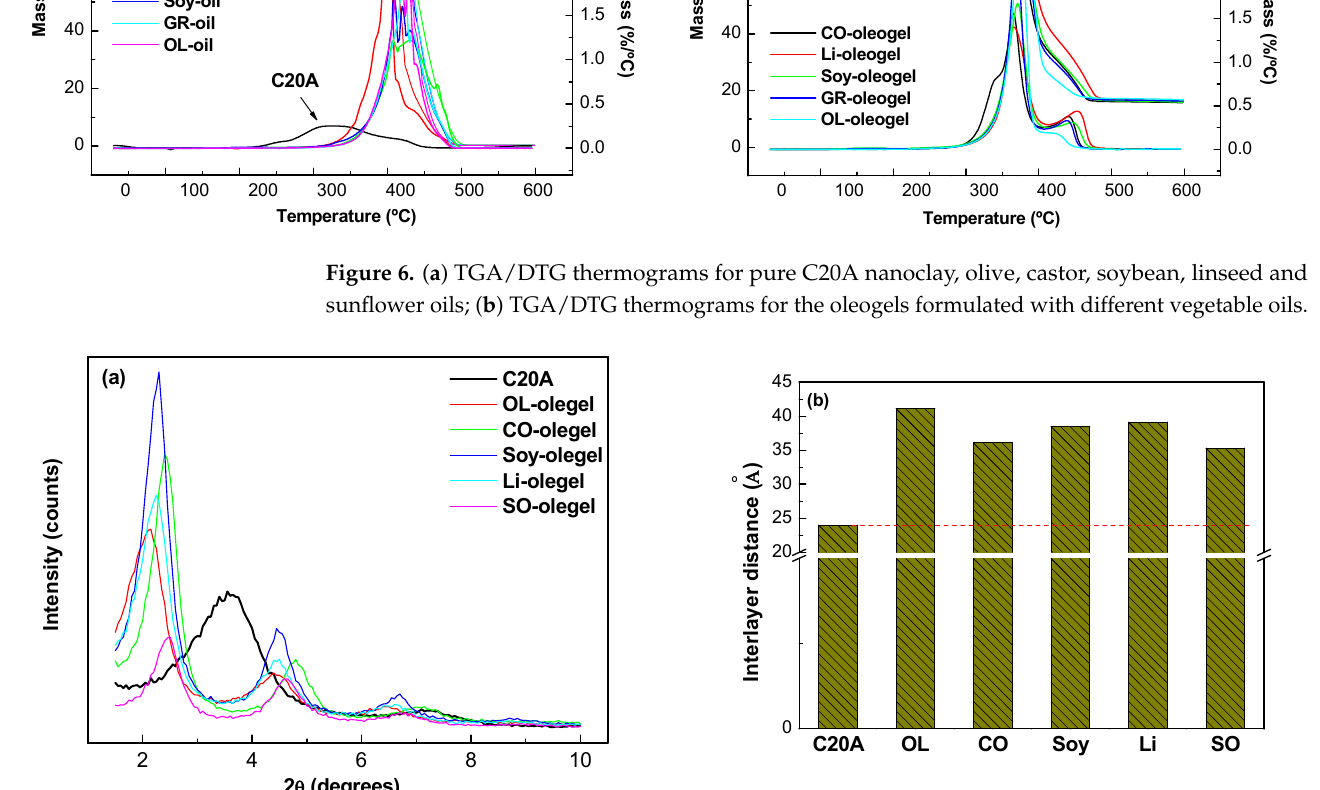
Figure 7. ( a ) X-ray diffractograms for oleogels as a function of vegetable oil. Pure C20A intensity profiles are also included for reference, and ( b ) Interlayer spacing obtained from diffraction peaks on C20A and different oleogels.